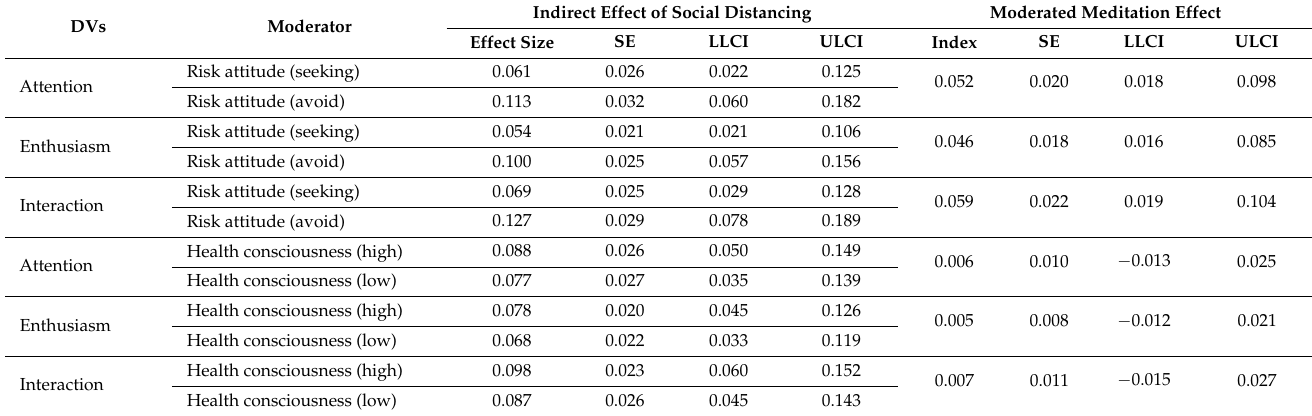
Table 6. Analysis results for the moderated mediation effect ( n = 589).